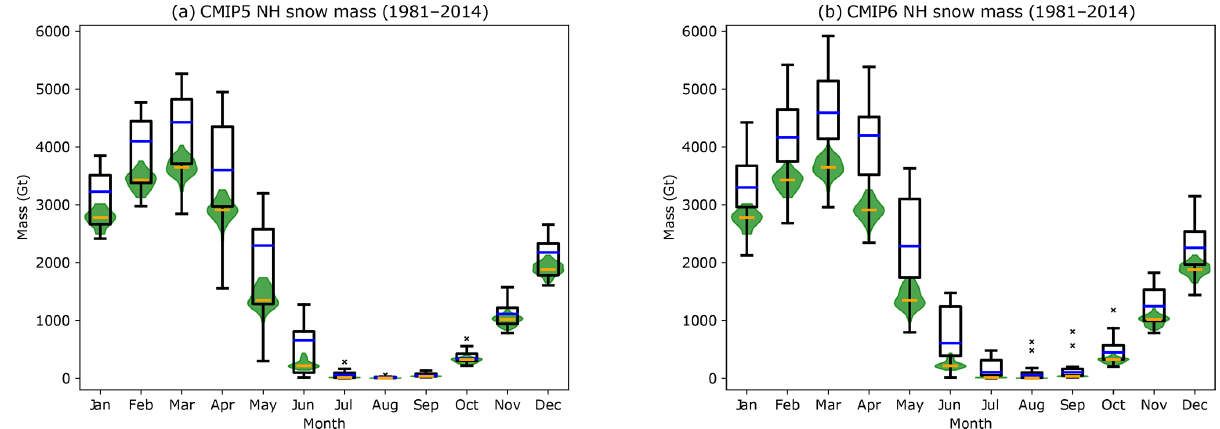
Figure 4. As in Fig. 3 but for snow